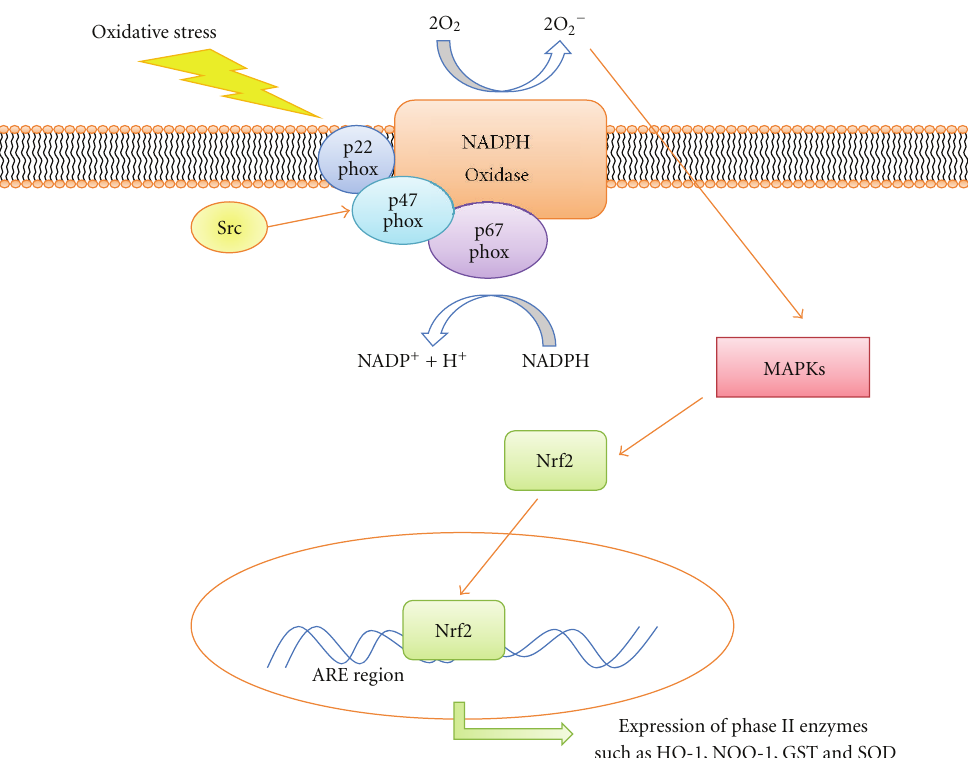
Figure 5: The role of Src under conditions of oxidative stress. Src has been shown to control NADPH oxidase activation and ROS production. NADPH oxidase is an enzymatic component of the production of ROS under various pathologic conditions. Activated NADPH oxidase is a multimeric protein consisting of at least three cytosolic subunits: p47phox, p67phox, and p40phox. The p47phox subunit plays a significant role in the acute activation of NADPH oxidase; the phosphorylation of p47phox is thought to inhibit intracellular interactions and promote the binding of p47phox to p22phox, thereby inducing the activation of NADPH oxidase. The expression of phase II and antioxidant enzymes is a defense mechanism that protects tissues from injury by ROS production. The phase II enzymes include the heme oxygenase-1 (HO-1), NADPH quinine oxidoreductase (NQO1), glutathione S-transferase (GST), and superoxide dismutase (SOD). These enzymes are expressed following NRF2 binding to the antioxidant response element